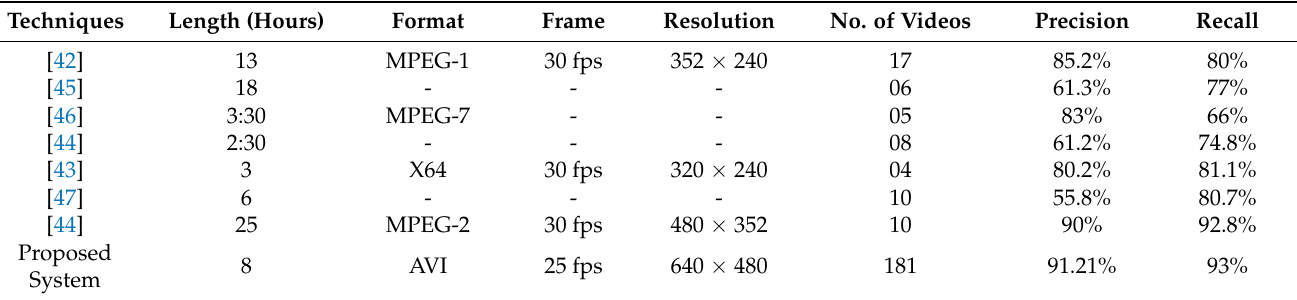
Figure 10. Visual representation of the performance of our proposed model.